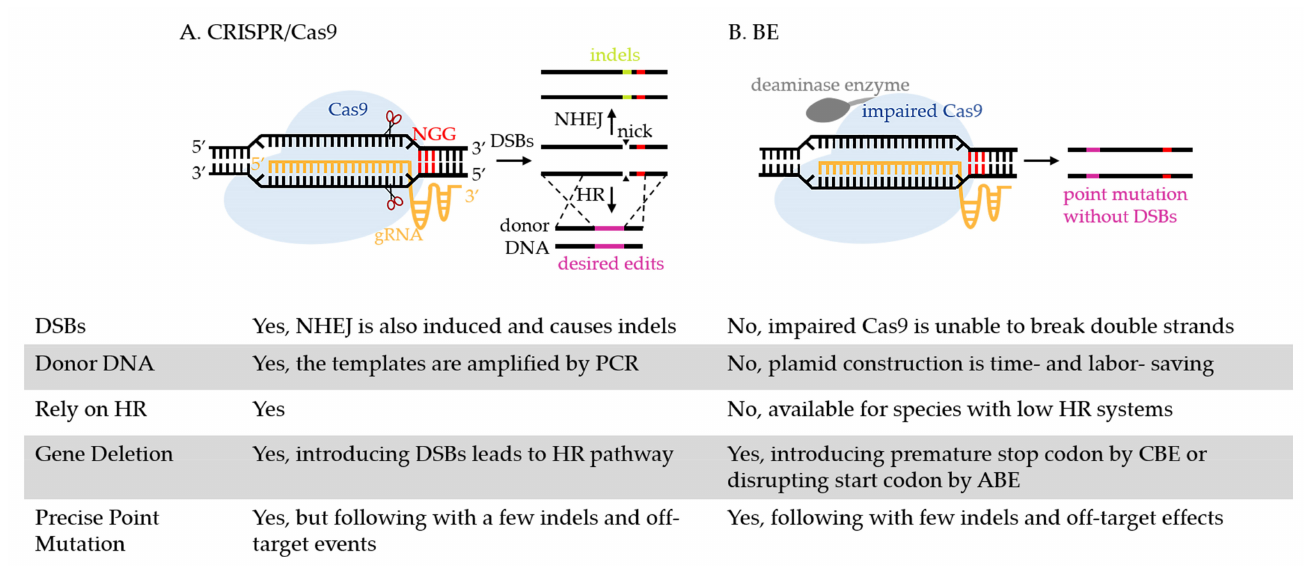
Figure 1. The process of gene editing using CRISPR/Cas9 and a BE. ( A ) Directed by gRNA, CRISPR/Cas9 recognizes the PAM site (5 (cid:48) -NGG-3 (cid:48) , highlighted in red) and introduces DSBs at the target. DSBs induces two cellular DNA repair systems, NHEJ and HR. Through NHEJ, a few imprecise indels are created through error-prone DNA repair. Through HR, the target is replaced by homologous donor DNA with desired edits and is therefore introduced with deletions, insertions, or substitutions of nucleotides. ( B ) The BE is also directed by gRNA to the target. At the target, deaminase enzyme achieves base conversion without causing DSBs and requiring donor DNA. CBE mediates the conversion of a C:G base pair to a T:A, which can replace four codons (CAA, CAG, CGA, TGG) with premature stop codons (TAA, TAG, TGA) to inactivate the gene. ABE mediates the base conversion from an A:T base pair to G:C, which can replace start codon ATG with GTG or ACG to disrupt the initiation of gene translation. Other than point mutation, BEs can achieve multiplex gene editing, in vivo evolution of protein and strain, metabolic engineering, etc., in various microbes, as discussed in detail